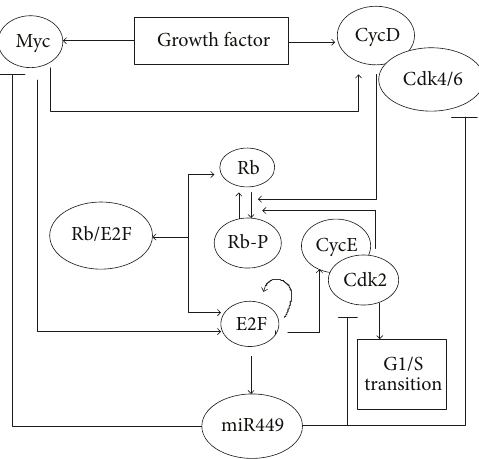
Figure 1: Rb-E2F pathway mediated by